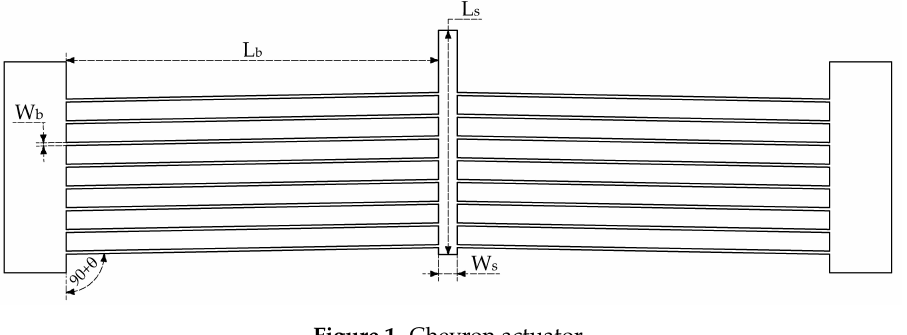
Figure 1. Chevron actuator.